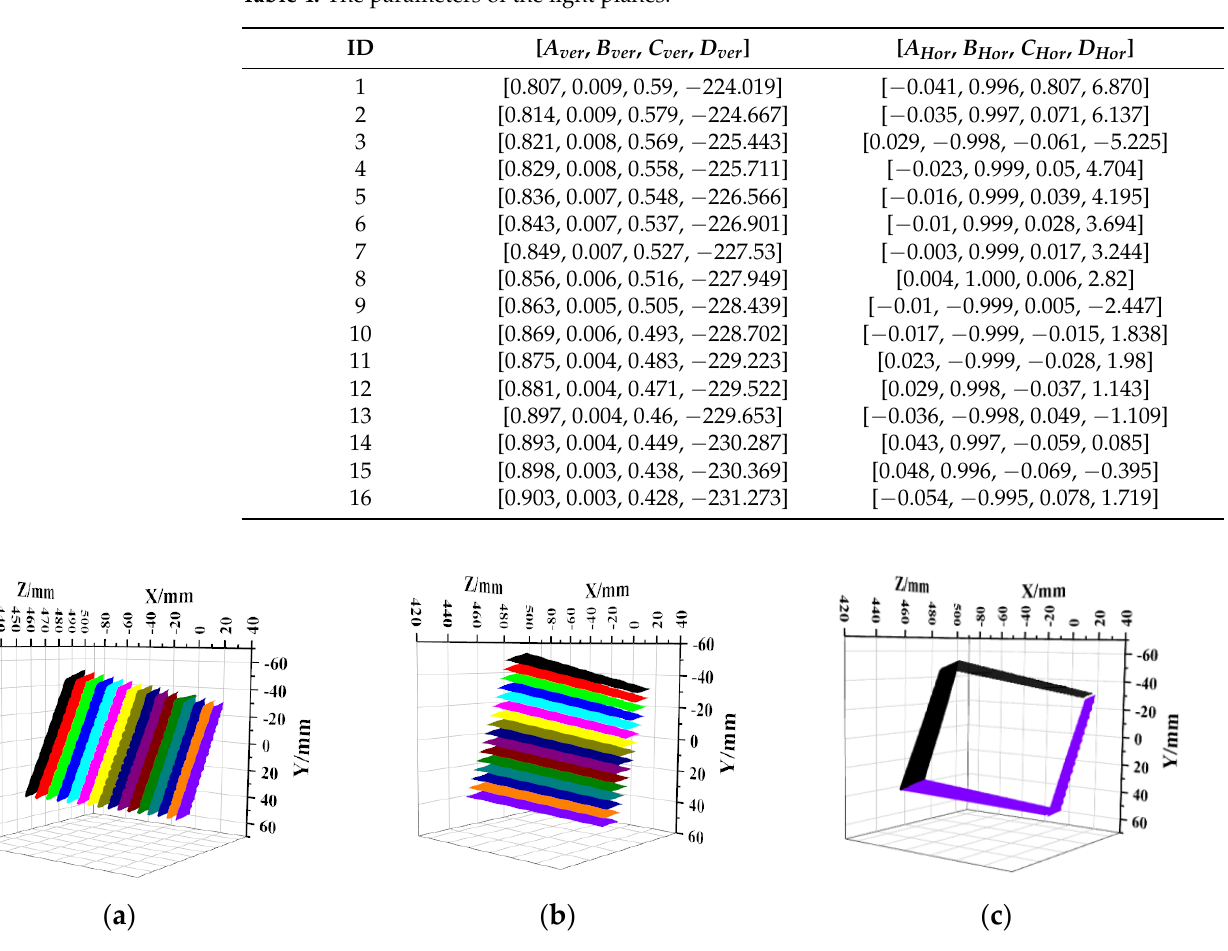
Table 4. The parameters of the light planes.